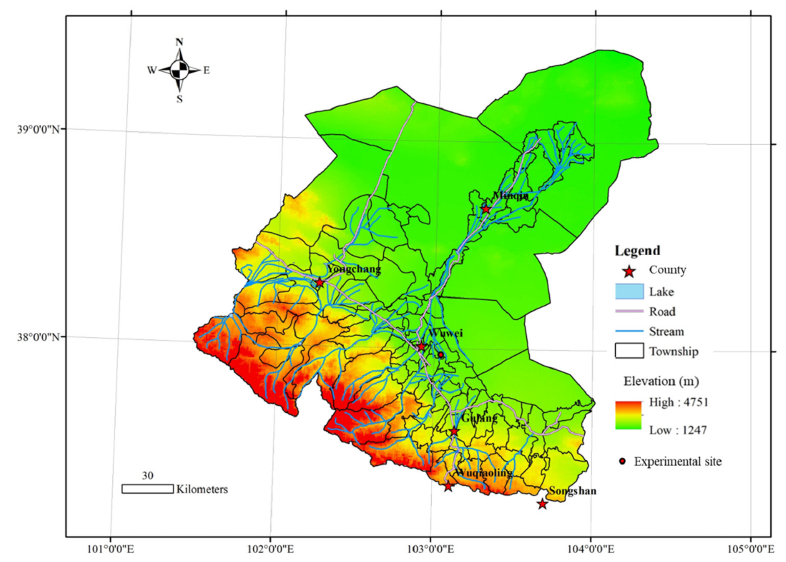
Figure 1. Map of the study area. Table 1. The statistics of the soil particle-size